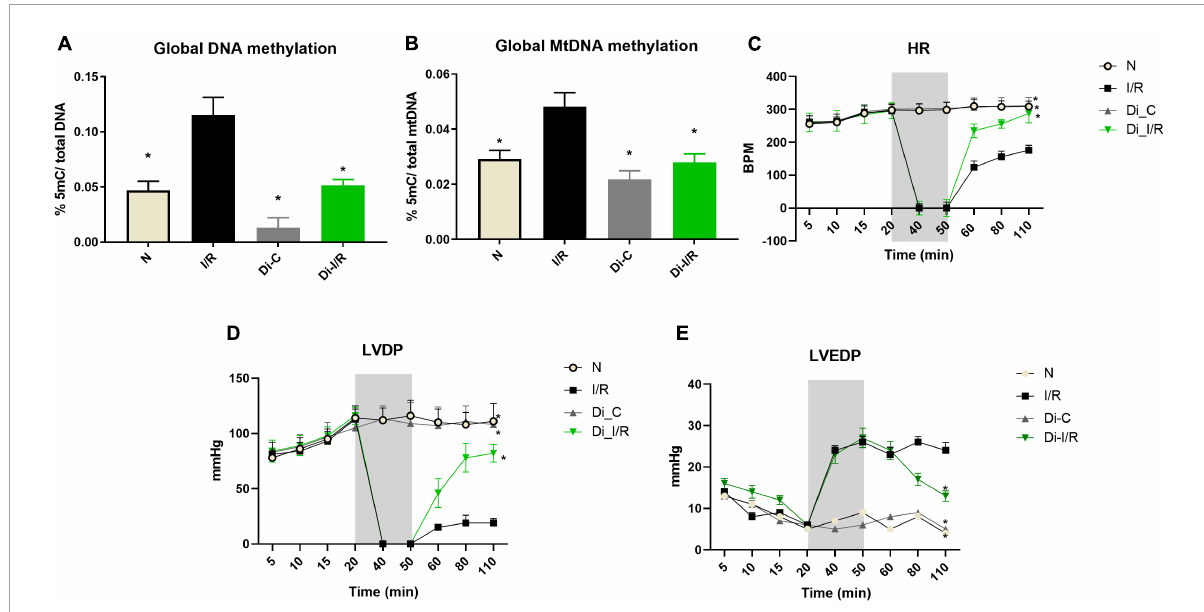
FIGURE4 Ischemia reperfusion (I/R) induced DNA methylation changes in the isolated rat heart model and compromised the cardiac function. Methylation changes induced by I/R was assessed in hearts of isolated rat heart from (A) %5-mC in nuclear DNA; (B) %5-mC in mitochondrial DNA. The changes in the hemodynamic indices were evaluated from (C) heart rate (HR); (D) LVDP; (E) LVEDP. * p < 0.05 vs.